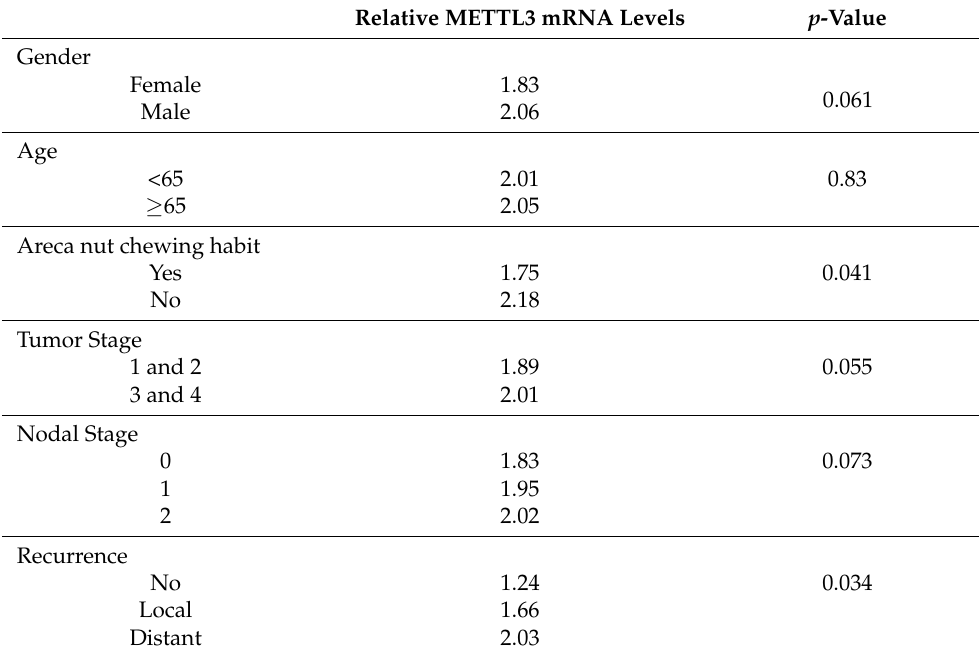
Table 1. The association between METTL3 expression and clinical parameters in 66 OSCC